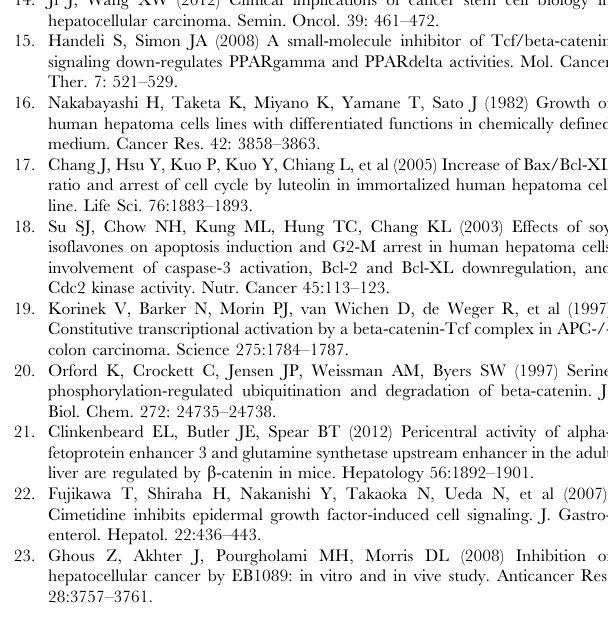
Figure S1 LCSC at passage 2 were used for flow cytometry assays. Cells were washed with 1 6 PBS and then treated with 2 ml